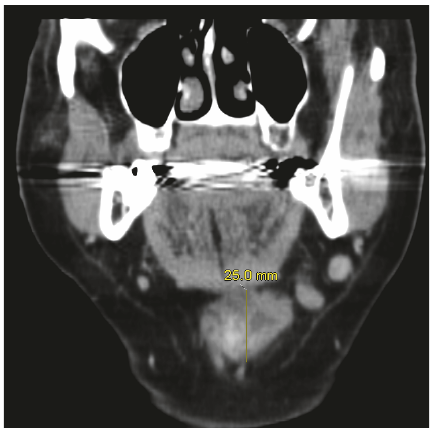
Figure 2: Axial view of the CT neck that showed presence of a neck mass measuring 25 mm in superior to inferior dimension.